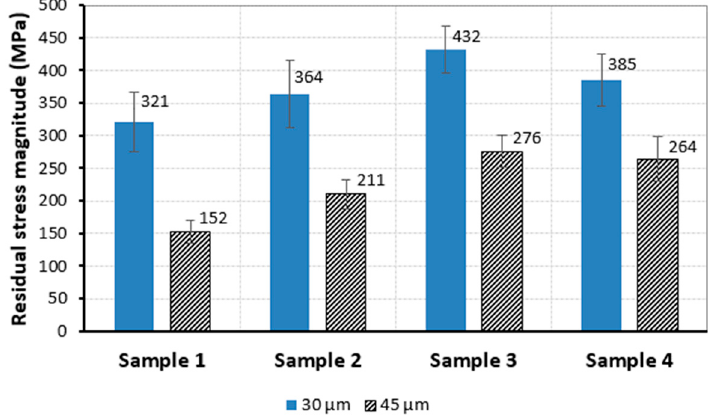
Figure 8. Residual stress magnitude comparison for 30-µm and 45-µm layer thicknesses at 180 W and 600 mm/s for samples manufactured on the EOSINT M280 machine. 600 mm / s for samples manufactured on the EOSINT M280